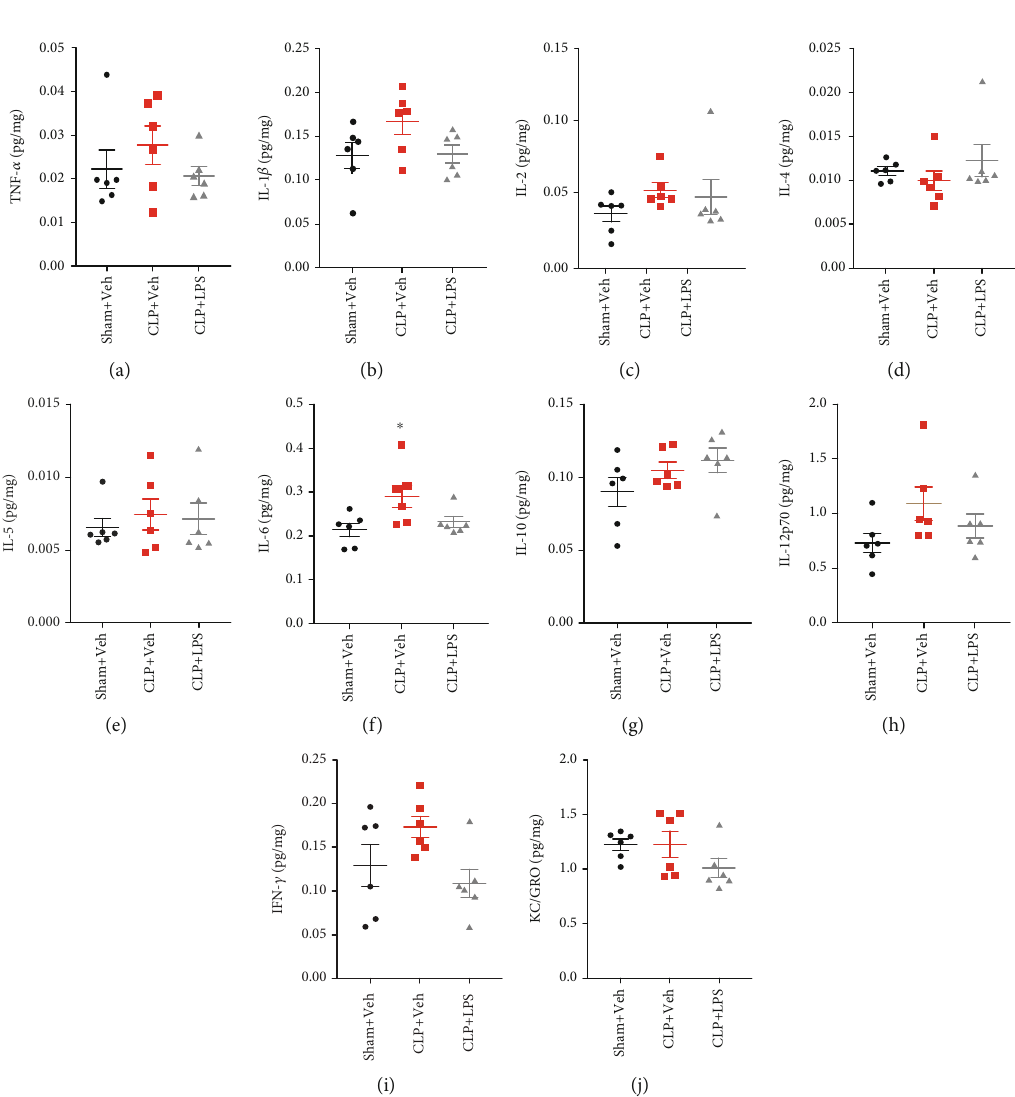
Figure 5: E ff ects of repeated LPS injections and CLP on prefrontal cortex cytokines. Tissue ELISA showed the increased IL-6 expression in the prefrontal cortex following CLP, which was not prevented by repeated LPS injections. Data represent mean ± SEM ; n = 6 /group. ∗ P < 0 : 05 vs. sham + Veh group; # P < 0 : 05 vs. CLP+Veh group. LPS: lipopolysaccharide; CLP: cecal ligation and puncture; Veh: